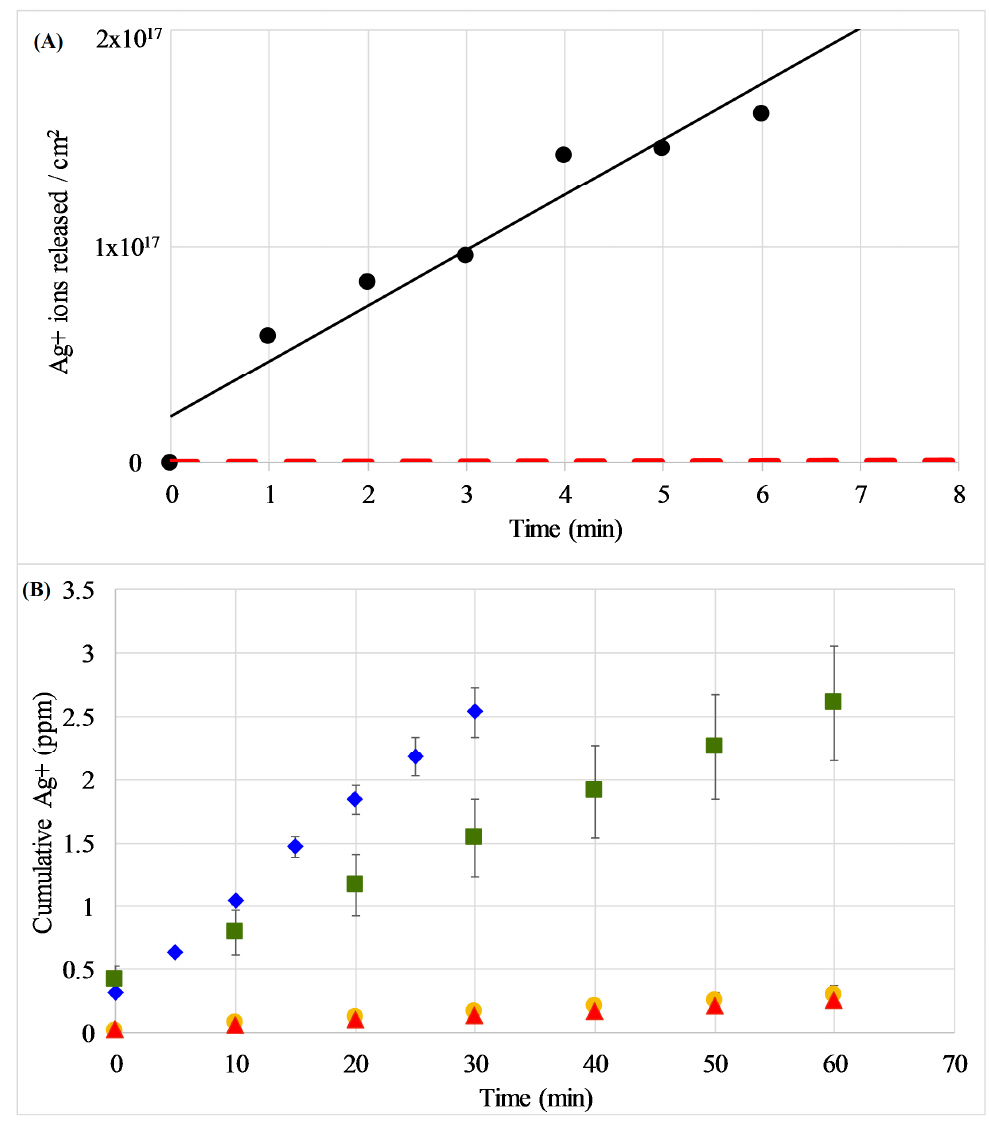
Figure 3. ( A ) Elution of Ag ions from Ag x O coatings (circles) in distilled water as measured by ICP-MS. Release profile is compared to estimated elution data from Ag nanoparticles (red dashed line near X -axis) from [21]; ( B ) Elution of Ag ions from Ag x O coatings in water (blue diamonds), PBS (green squares), LB growth medium (yellow circles) and DMEM growth medium (red triangles) as measured by ICP-MS. Data are averages with standard deviations of at least three replicates. In some cases, the error bars are smaller than the size of the symbol.